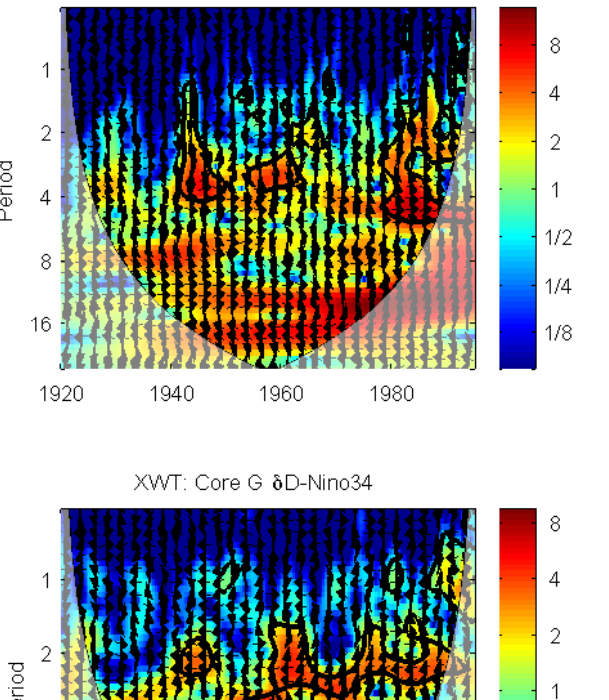
G δ D and Core G Net Accumulation XWT from 1657-1995. Middle) Core G δ D and Ni˜no 3.4 XWT from 1950-1995. Figure A.2. Top) Core Bottom) Core G δ D and SAM XWT from 1979-1995. www.jn.net